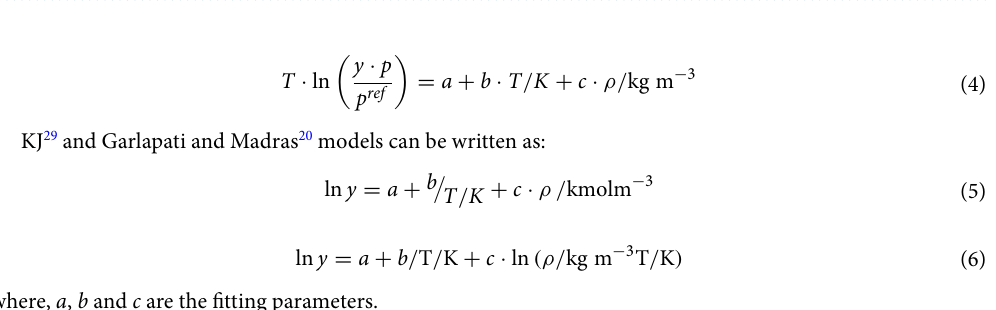
Table 2. The solubility of decitabine as a function of temperature and pressure based on mole fraction (Standard uncertainties, u, are u (T) = 0.1 K and u (P) = 0.35 bar).